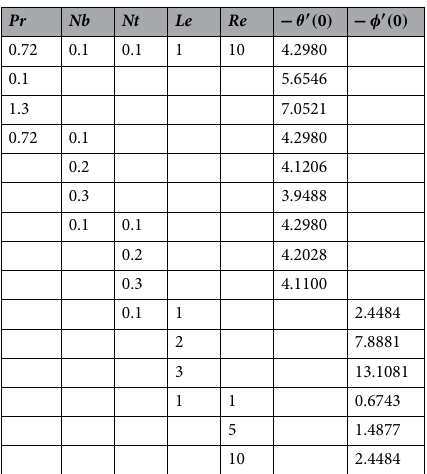
φ ′ ( 0 ) for varying Pr , Nb , Nt , Le and Re −